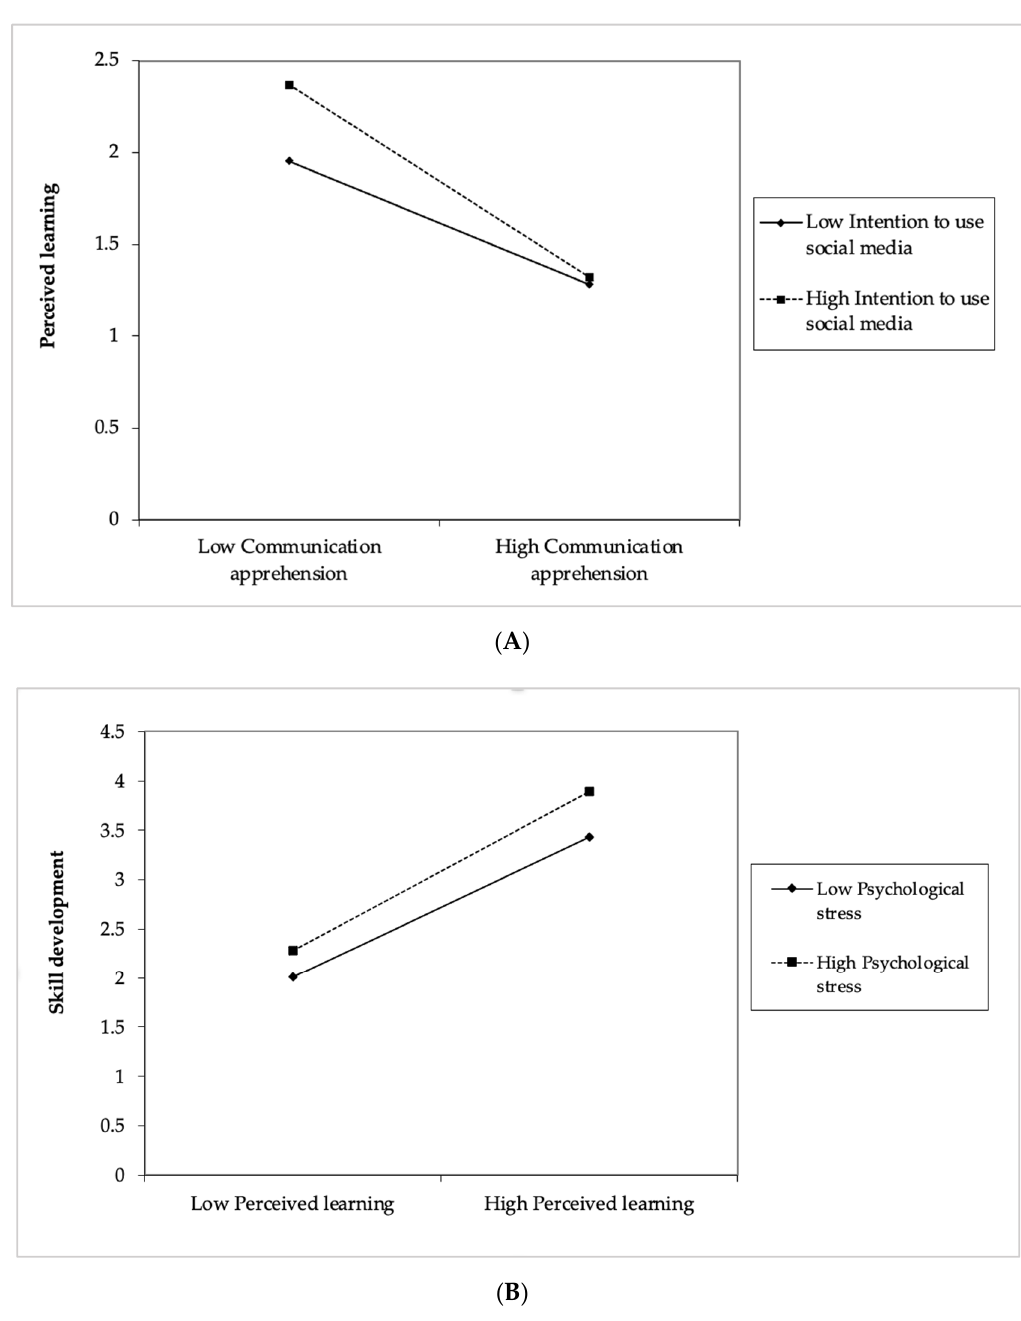
Figure 3. Moderating Effects: ( A )—Moderating effects of the intention to use social media on communication apprehension and perceived learning; ( B )—Moderating effects of psychological stress on perceived learning and psychological well-being.